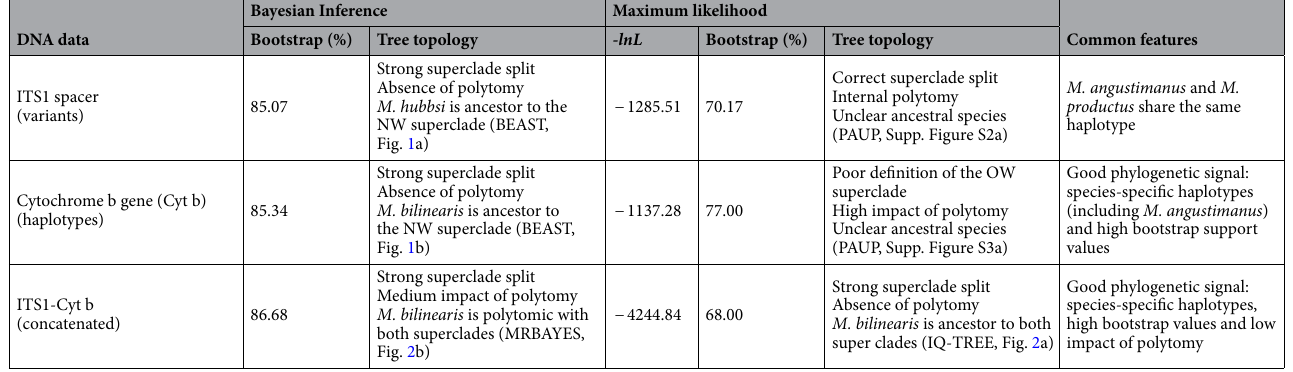
Bayesian Inference